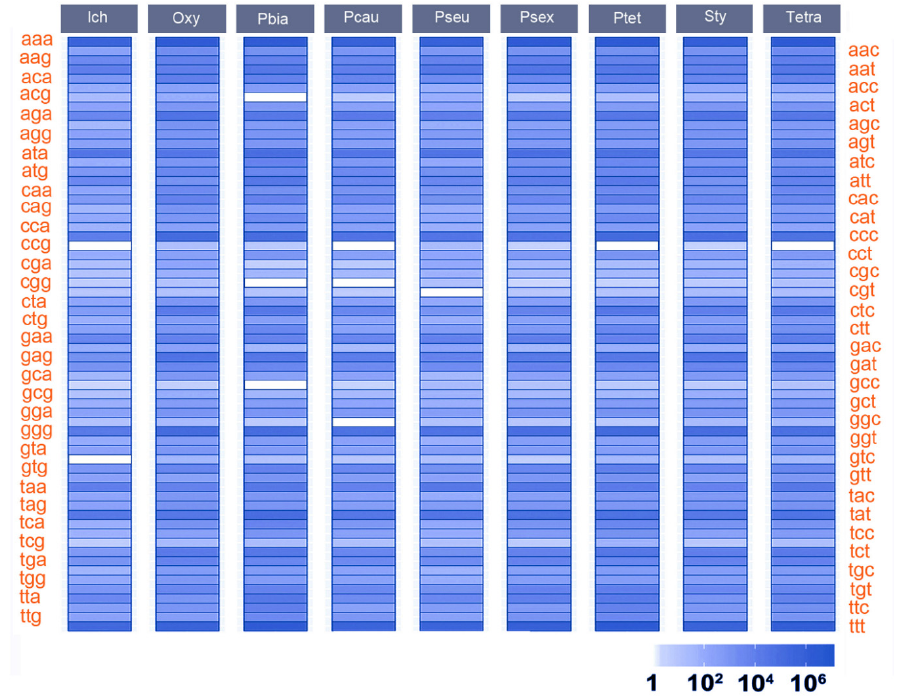
Figure 4. Numbers of codons that are in SSR regions. White boxes represent 0. Ich, Ichthyophthirius multifiliis ; Oxy, Oxytricha trifallax ; Pbia, Paramecium biaurelia ; Pcau, P. caudatum ; Psex, P. sexaurelia ; Ptet, P. tetraurelia ; Pseudo, Pseudocohnilembus persalinus ; Sty, Stylonychia lemnae ; Tetra, Tetrahymena thermophila .